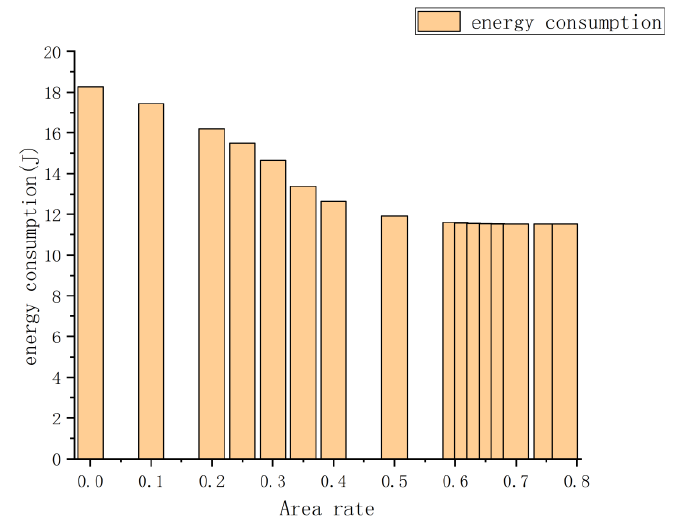
Figure 10. Energy consumption with different area ratio textured.